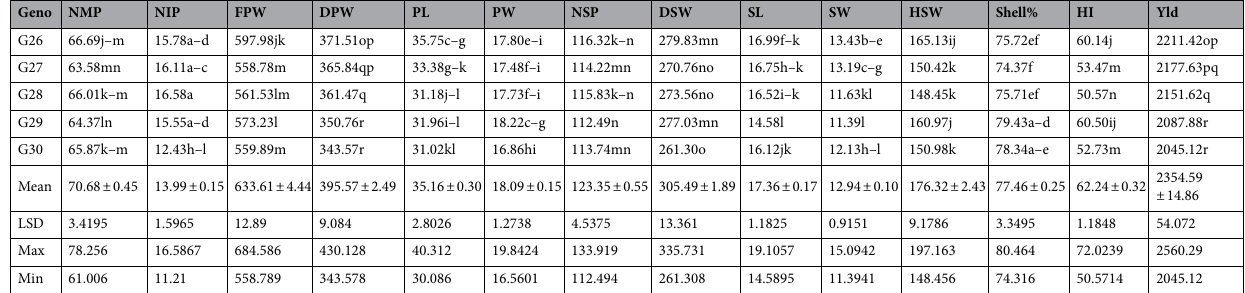
Table 7. Means performance and comparison of 30 Bambara groundnut genotypes tested four environments. Geno genotypes, LSD list significant difference, DTE Days to emergence (d), Days to 50% flowering (d), DTM Days to maturity (d), PH Plant height (cm), NB Number of branches per plant, NS Number of stems per plant, NP Number of petioles per plant, NL Number of leaves per plant, NNS No. of nodes per stem, IL Inter nodes length (cm), BFW Biomass fresh weight per plant (g), BDW Biomass dry weight per plant (g), TNP Total no. of pods per plant, NMP Number of mature pods per plant, NIP Number of Immature pods per plant, FPW Fresh pods weight (g), DPW Dry pods weight (g), PL Pod length (mm), PW Pod width (mm), NSP Number of seeds per plant, DSW Dry seed weight per Plant (g), SL Seed length (mm), SW Seed width (mm), HSW hundred seed weight (g), Shell % Shelling percent, HI Harvest index (%) and Yld Yield